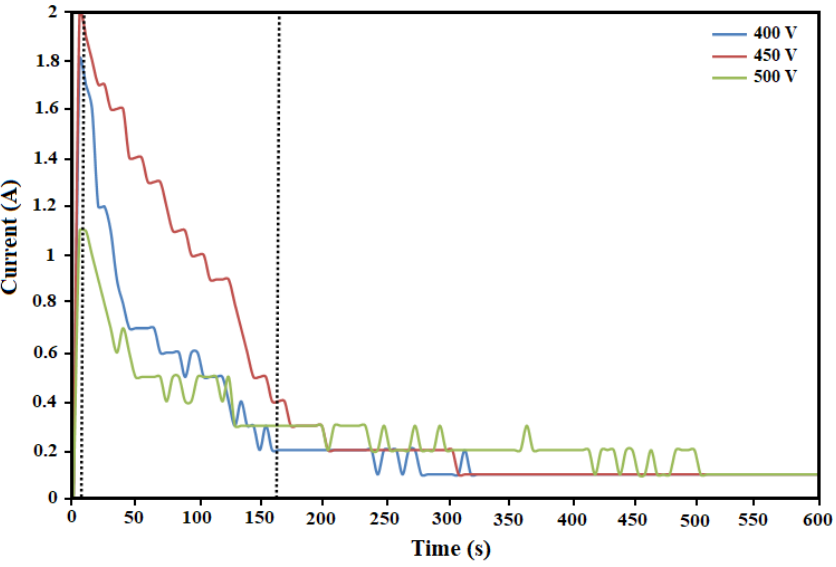
Figure 1. Current-time curves of γ -TiAl specimens during the PEO coating process under applied Figure 1. Current- time curves of γ -TiAl specimens during the PEO coating process under applied voltages of 400 V, 450 V, and 500 voltages of 400 V, 450 V, and 500 V.